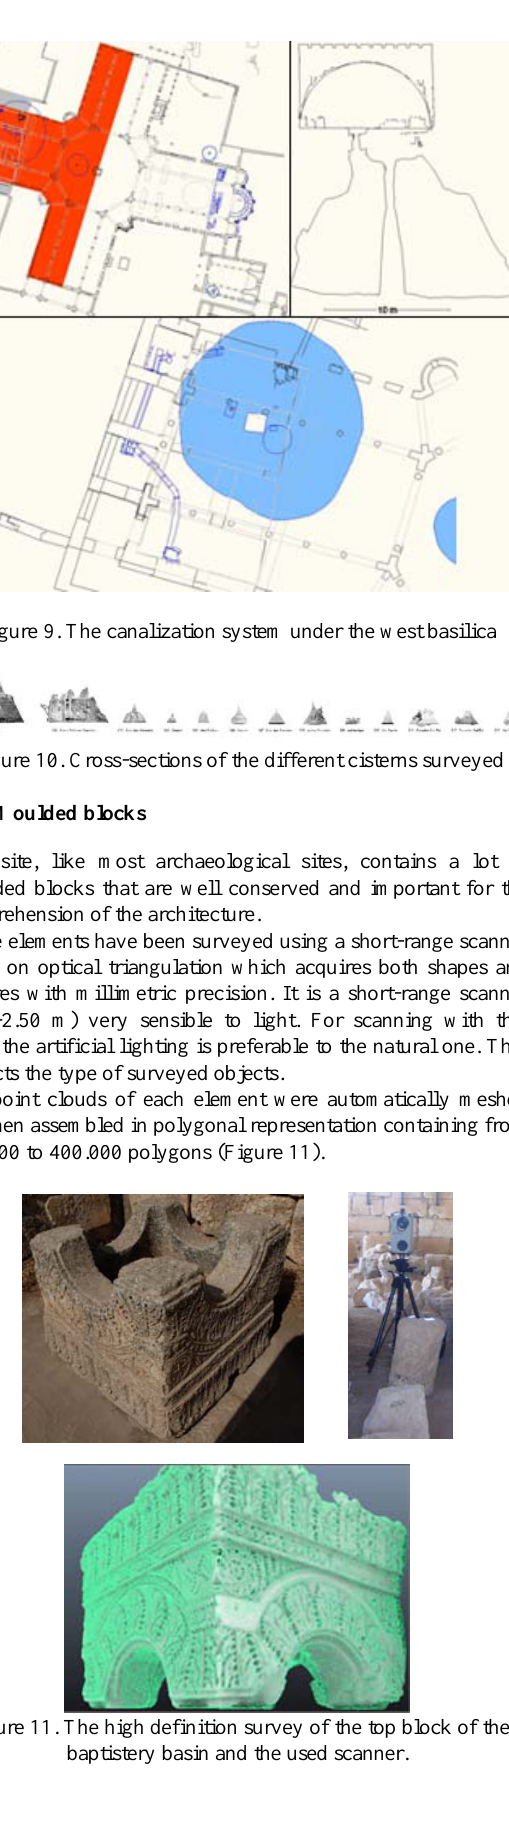
Figure 13. The triumphal arch and